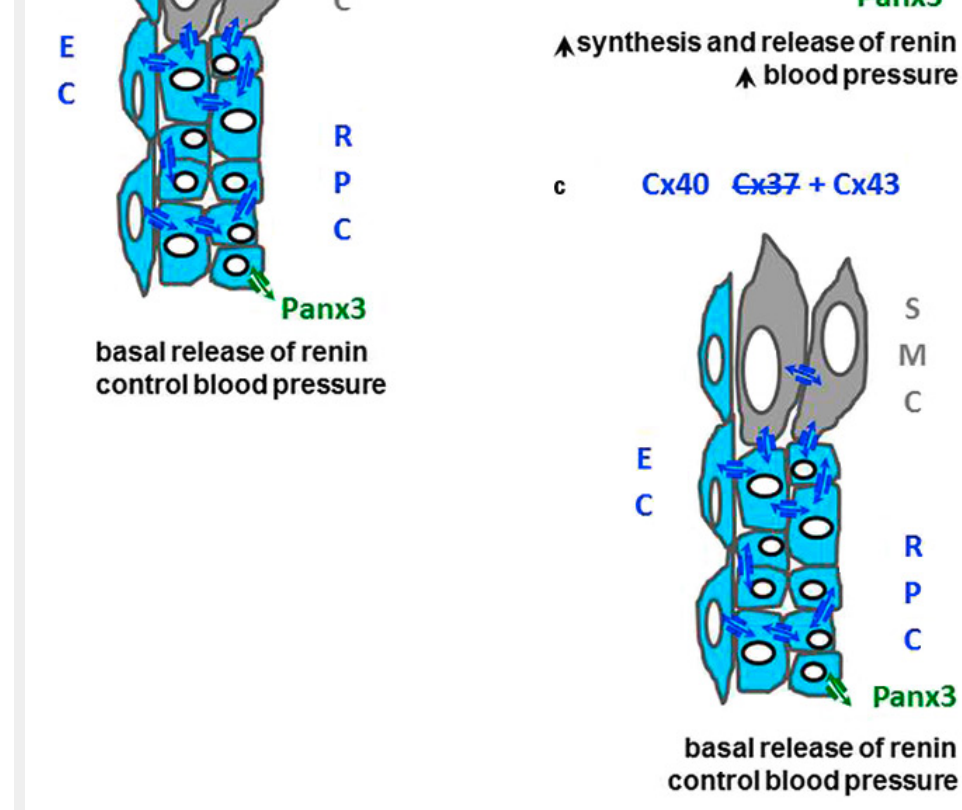
Figure 3 Cx40, Cx37, Cx43 and the renin-producing cells. (a) Within the renal cortex, renin-producing cells (RPC) are coupled by Cx37 and Cx40 channels, to companion cells and nearby endothelial cells (EC), and also express Panx3. The smooth muscle cells (SMC, grey) of the afferent arterioles are coupled by Cx43 channels to companion cells and to RPC. (b ) Loss of Cx40 increases the major function of RPC, i.e. renin biosynthesis and secretion, resulting in persistent hypertension. These changes are also observed when cells express the A96S variant of Cx40 ( b ), but not after deletion of Cx37 ( c ). The alterations in renin secretion observed under such conditions mimic those observed in most forms of